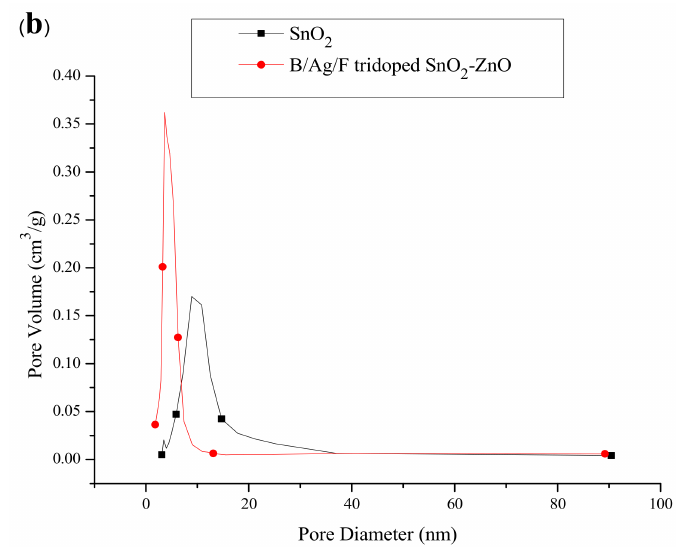
Figure 8. ( a ) N 2 adsorption/desorption isotherms and ( b ) pore size distribution of pure SnO 2 and B/Ag/F tridoped SnO 2 -ZnO powders heated at 550 ◦ C in atmosphere for 1 h.